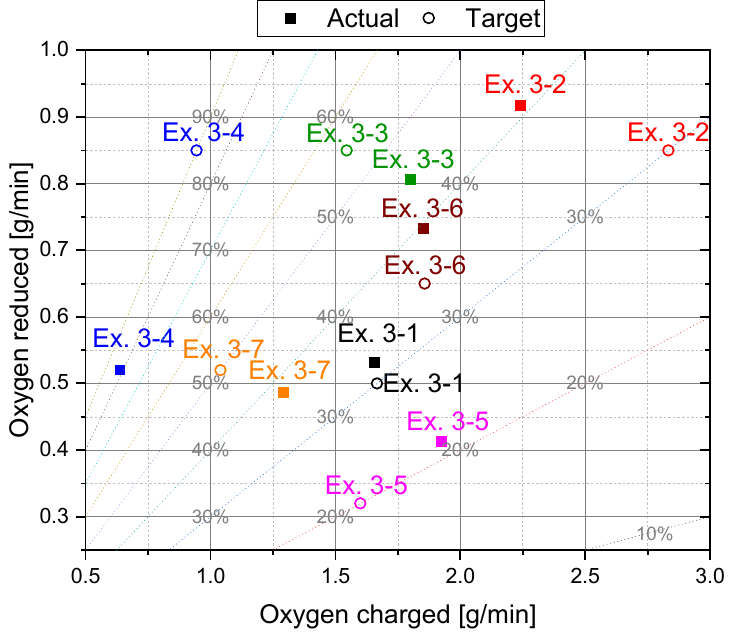
Figure 9. Reduced and charged oxygen during the charging phase for the main trials. In Ex. 3–1 as well as in Ex. 3–5 to Ex. 3–7 the hydrogen content during iron ore feeding was changed and resulted in three peaks in the evaluation of the hydrogen utilization degree, which can be seen from Ex. 3–7, Figure 10. In peak I, when hydrogen was added to the reaction zone for pre-reduction, the mass spectrometer detected the H 2 content with a delay. The reason for this is, on the one hand, the volume of the reactor and exhaust system, through the gas exchange between hydrogen and the therein contained argon. On the other hand, the spectrometer’s measuring interval recorded the exhaust gas composition every 6.7 s. This means that hydrogen was already available for the reduction but was not yet detected in the exhaust gas, which resulted in an apparent utilization rate of 100%. The reverse mechanism occurred when the hydrogen content was reduced for the charging phase, peak II. Higher H 2 contents in the exhaust gas were detected by the spectrometer compared with the available content in the reaction zone. This resulted in conversion rates of 0% in the calculation. After a settling time, however, an equilibrium was reached between the introduced and detected hydrogen in the off-gas. At the last peak (III), the exact mechanism described at peak (I) occurred when the hydrogen content increased. To calculate the average conversion degree during charging, only the nearly constant range (between II and III) was